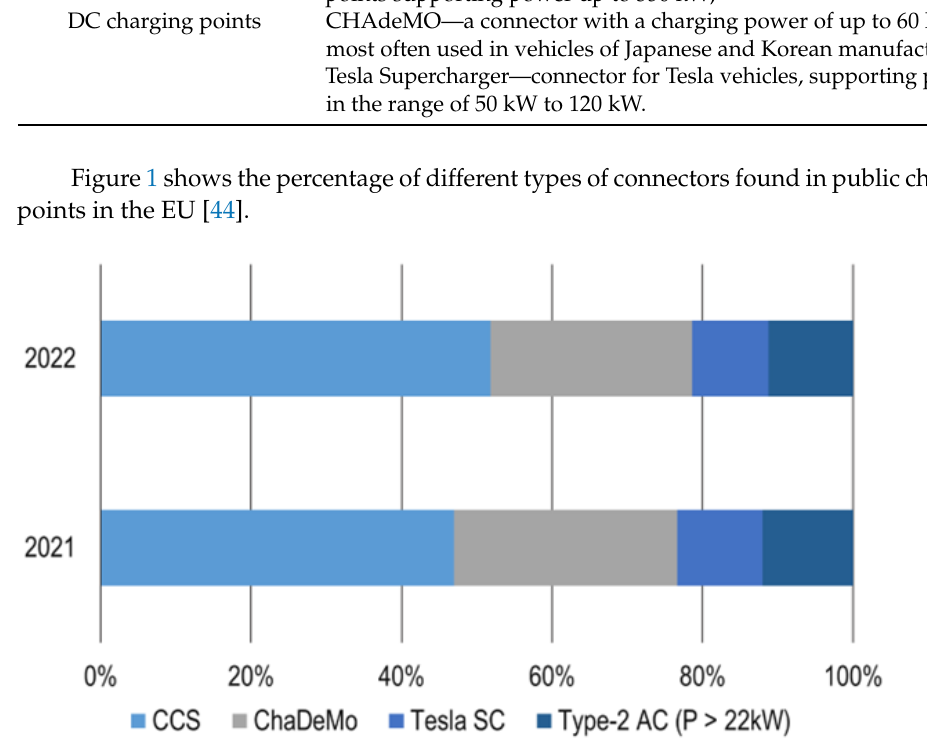
Table 2. Type of connectors available at public charging points.